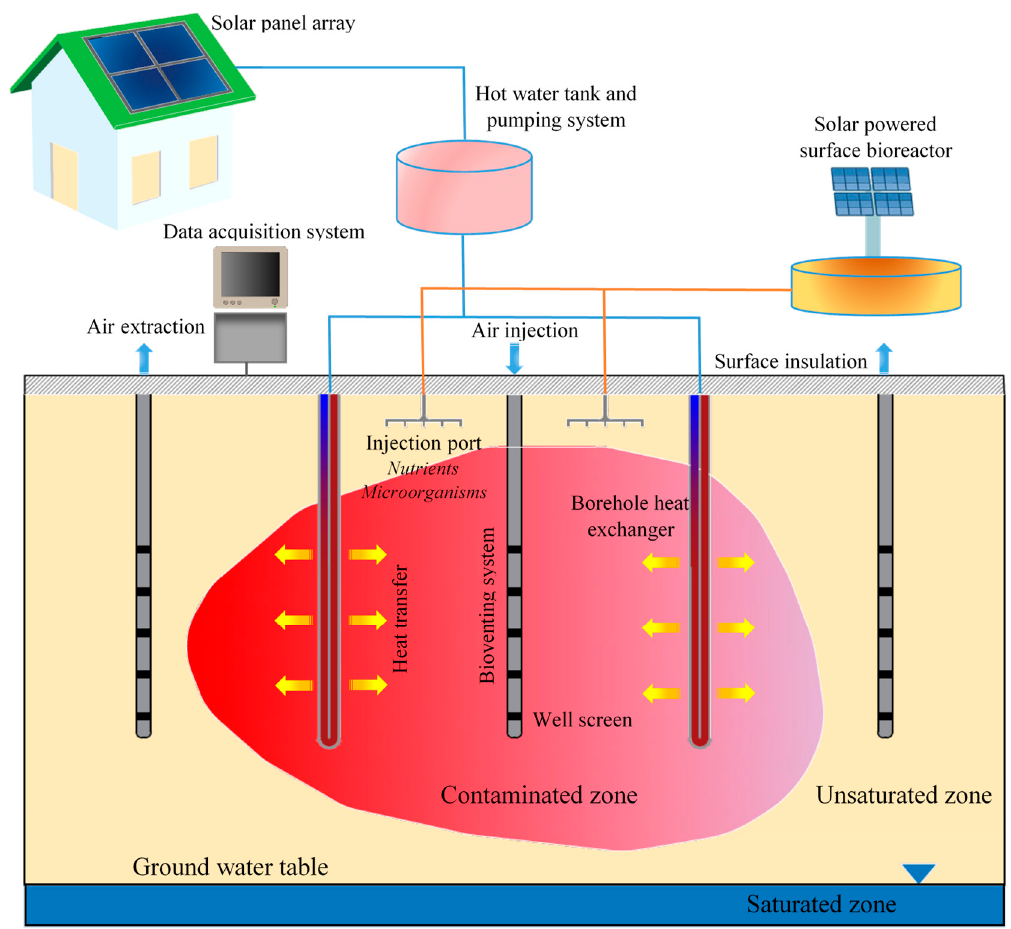
Figure 1. Schematic of the proposed coupled enhanced bioremediation–energy storage system.